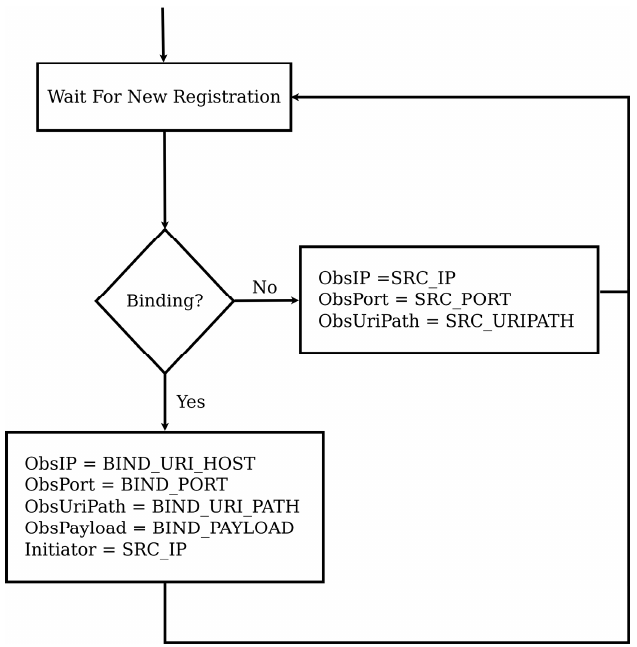
Figure 5. Flow Chart Showing Binding Relationship Establishment.